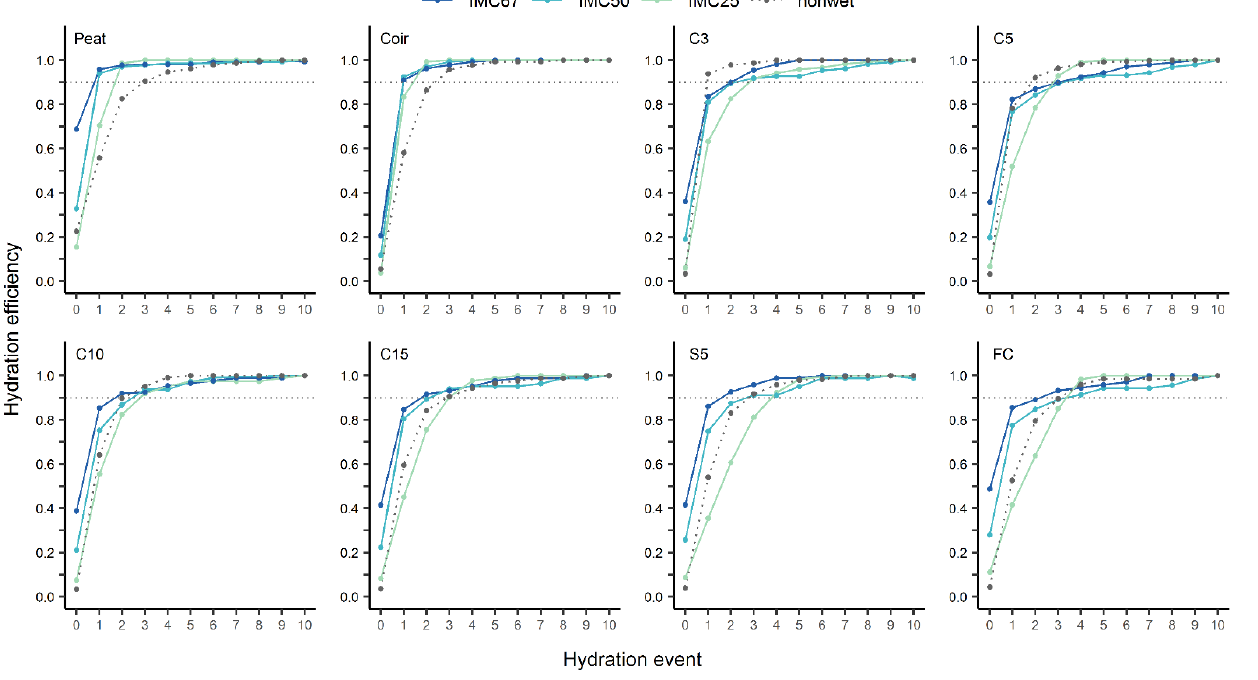
Figure 6. Hydration efficiency curves of peat, coir, and six processed miscanthus substrates at different initial moisture content (67% w, 50% w, 25% w, and non-wet). In each curve, each point represents for the ratio of cumulative water retention at each event to the maximum water retention within 10 events (hydration efficiency). The dotted reference line represents for hydration efficiency of 90%. Each data point is a mean of 4 replicates. Miscanthus × giganteus was harvested with a forage harvester (FC, field-chips), then processed with a mechanical fraying facility through a 5-mm screen (S5, shreds) or a hammermill with screen sizes of 15, 10, 5, and 3 mm (C15, C10, C5, and C3, chips). Commercial peat substrate amended with 30%